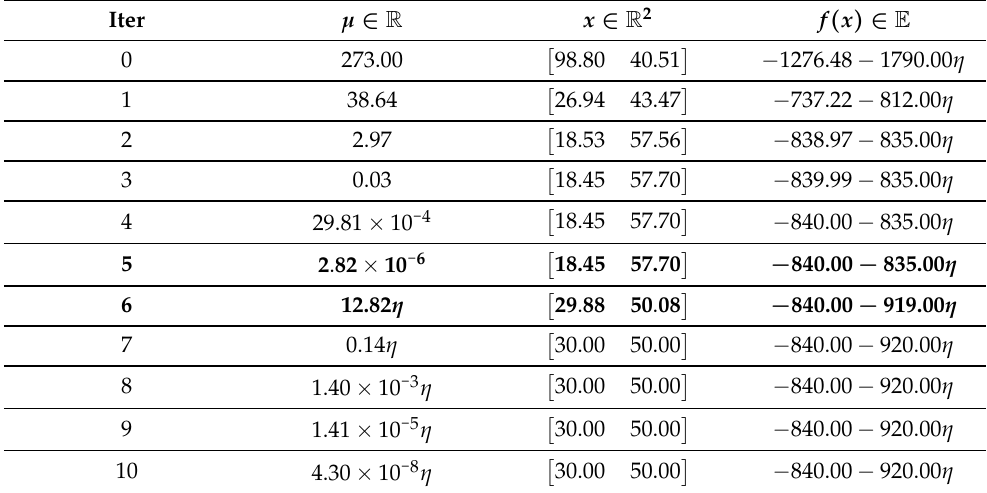
Table 1. Iterations of the NA-IPM solving the problem in